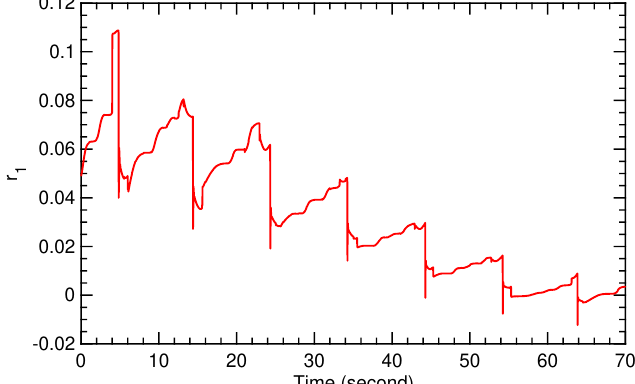
Figure 15. Time history of controller parameter r 1 for flight condition I.